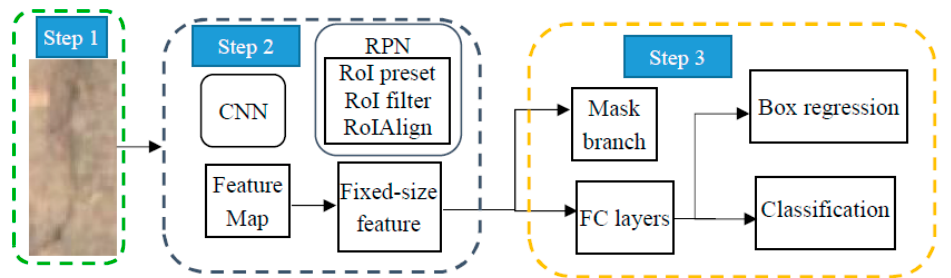
Figure 4. The procedure of Mask R-CNN for crack detection.